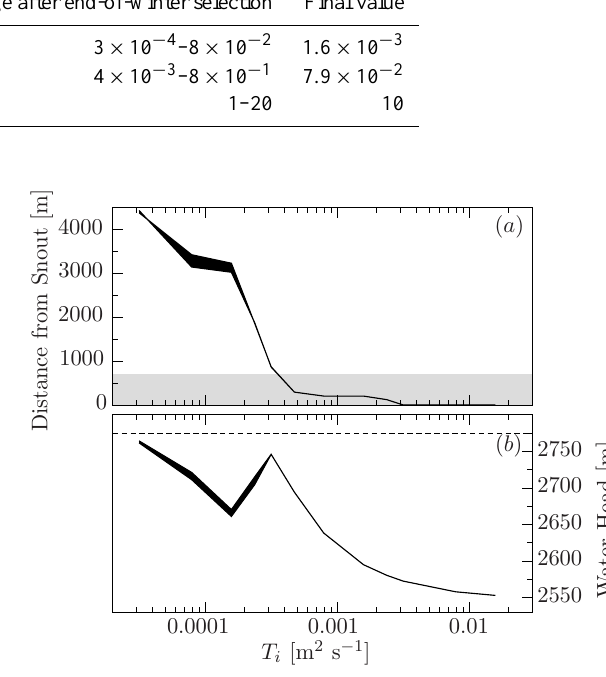
Fig. 6. Length of the EPL (a) and IDS water head in the borehole array (b) as a function of the IDS transmissivity T i . The grey zone in (a) indicates the admissible values for the EPL maximum length. The dashed line in (b) represents the flotation limit. The spread of the curves represents the scattering due to EPL transmissivity rang- ing from 4 × 10 − 3 to 8 × 10 − 1 m 2 s − 1 , with the higher transmissivity values leading to the lowest EPL length and IDS water